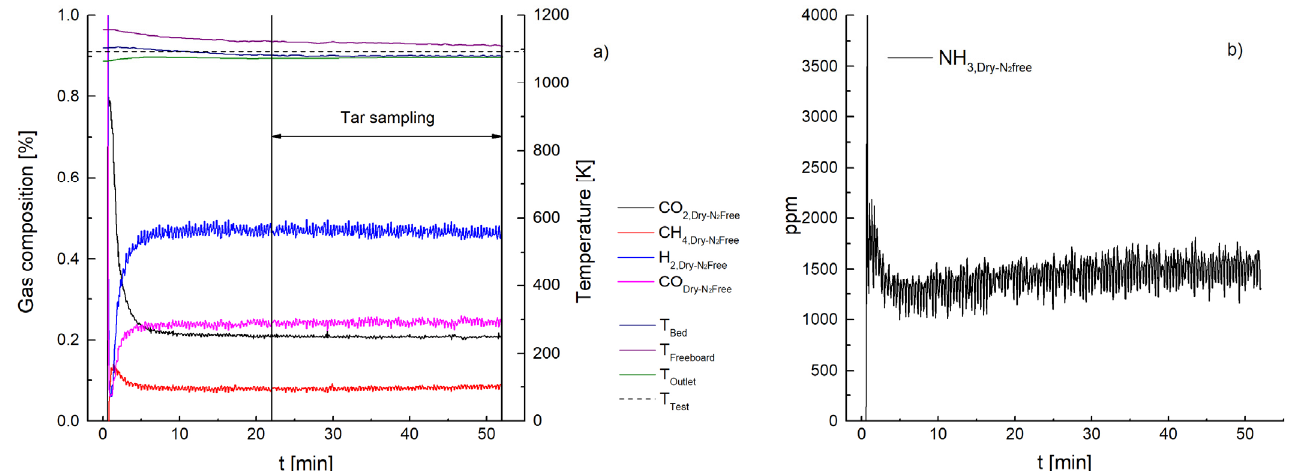
Figure A4. Temperature and gas composition ( a ) and ammonia content ( b ) during test 4.